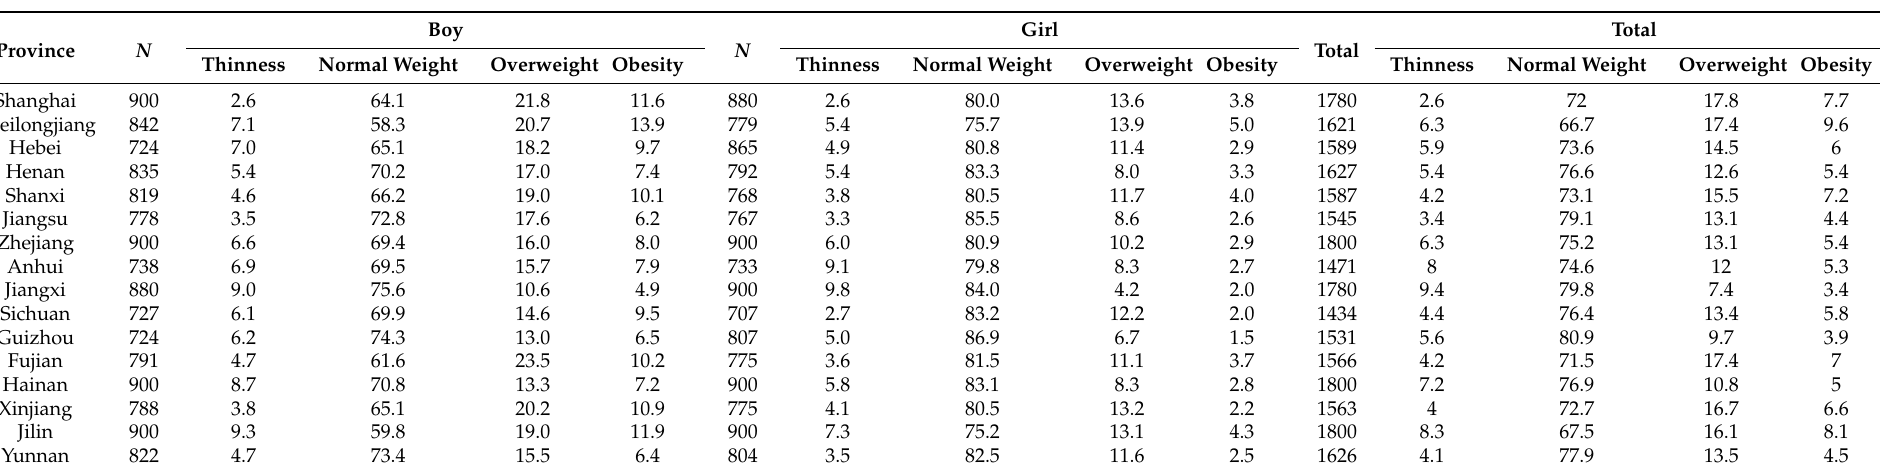
Table 3. Prevalence of nutritional status of children and adolescents in different provinces